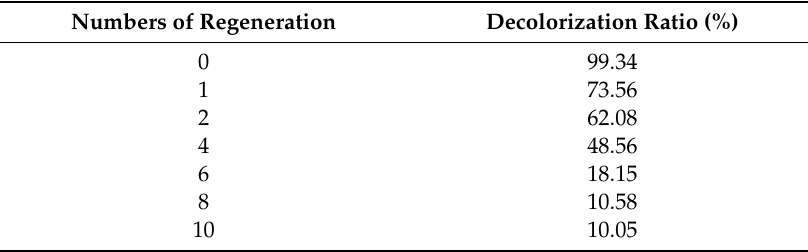
E ff ect of number of regenerations on regeneration ratio under a 0.2 mol / L HCl concentration